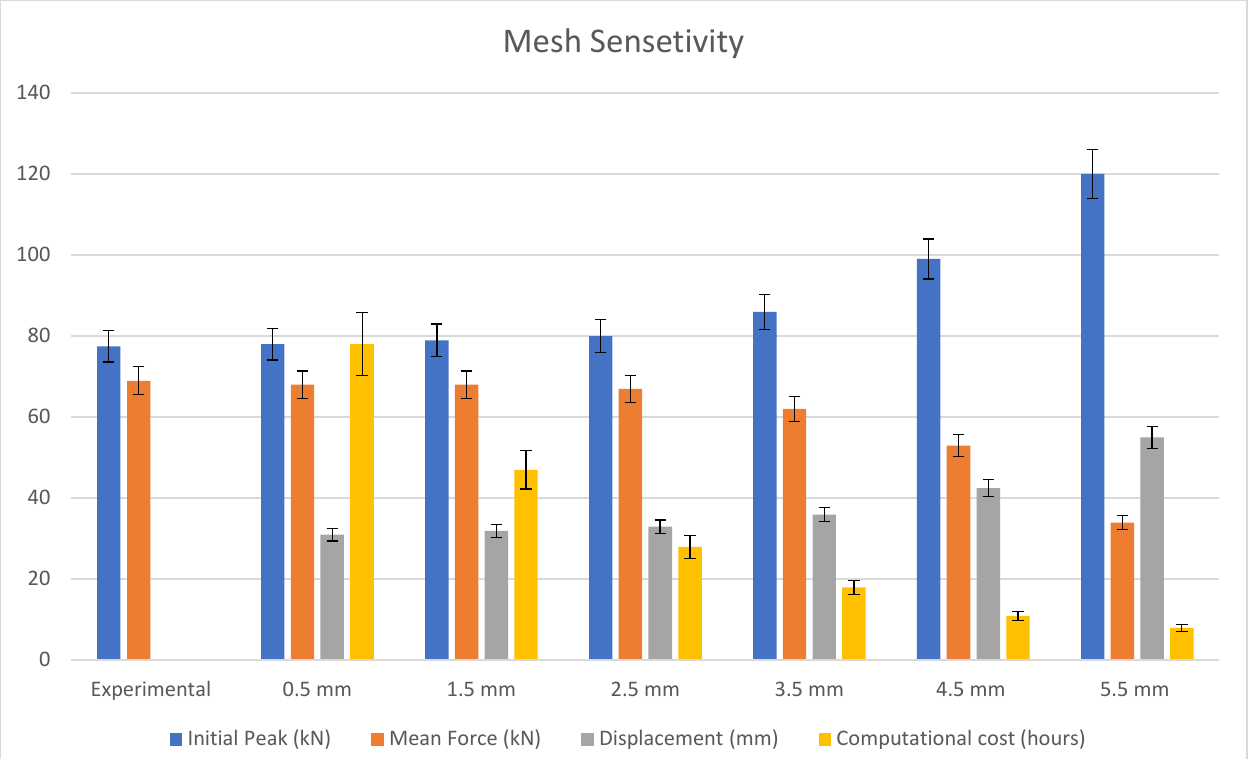
Figure 7. Mesh sensitivity comparison [66].